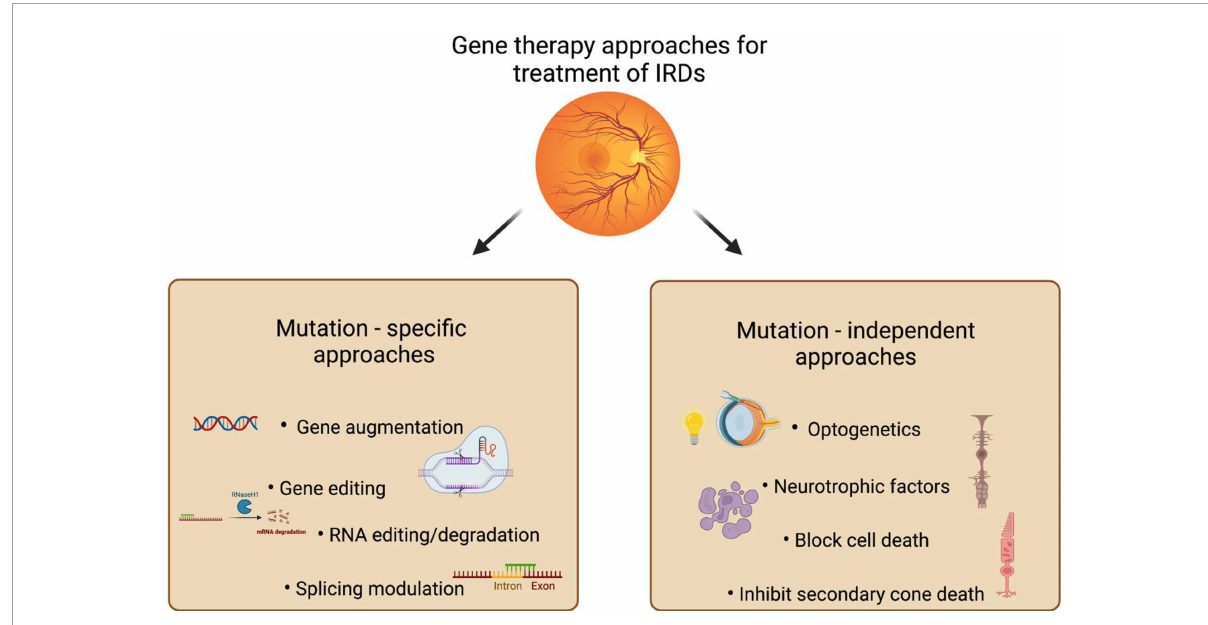
FIGURE2 Gene therapy strategies for IRDs. This schematic represents the potential therapeutic approaches that gene therapy offers for various retinal diseases. Gene/mutation-based approaches are preferred when the knowledge of the genetic cause of the disease are known. Mutation-independent approaches act on common pathways that underly retinal damage and help in treating a large fraction of patients with genetically heterogeneous and complex retinal